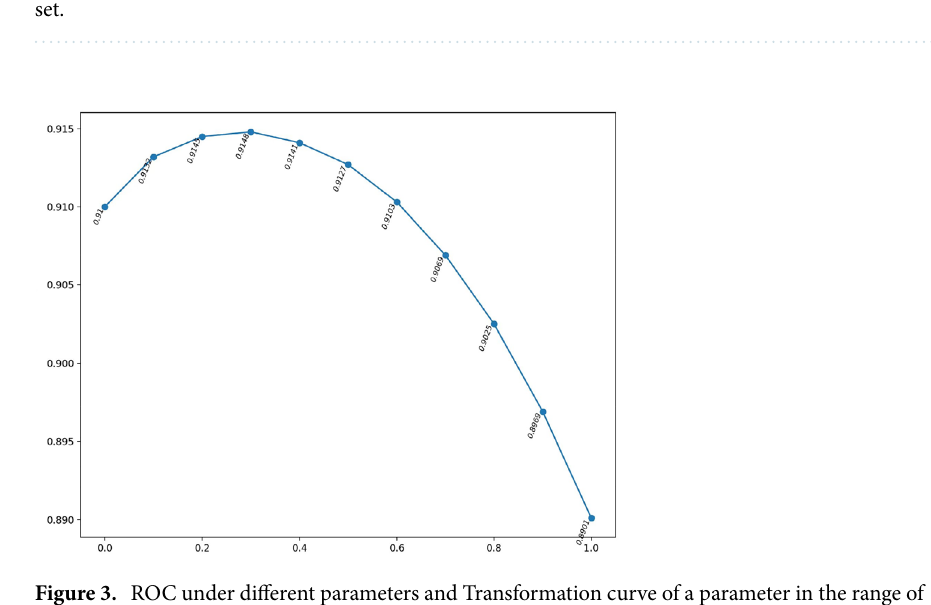
Figure 3. ROC under different parameters and Transformation curve of a parameter in the range of [0,1].